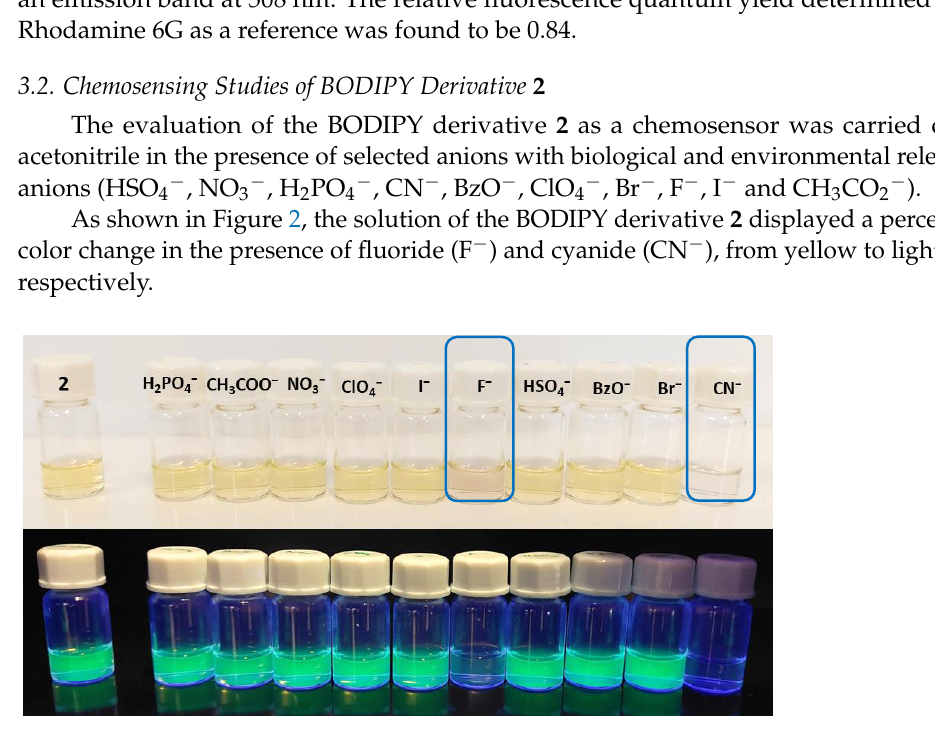
Figure 2. Preliminary evaluation of BODIPY derivative 2 as colorimetric ( top ) and fluorimetric ( bottom , visualized under a UV lamp at 365 nm) chemosensor in the presence of several anions (50 equivalents) in acetonitrile solution.